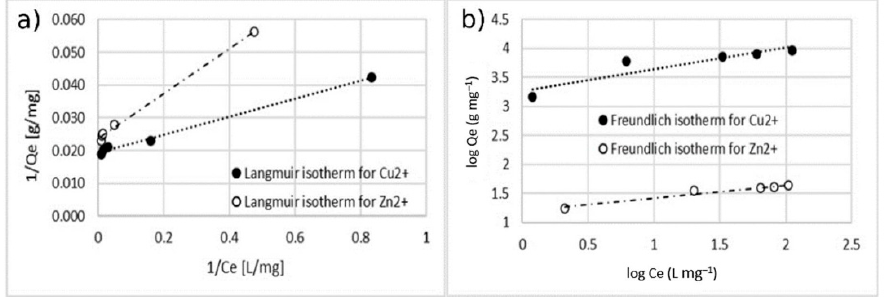
Figure 14. Adsorption isotherm for adsorption of Cu 2+ and Zn 2+ using MA with 5% w / w of coating. ( a ) Langmuir model and ( b ) Freundlich model.